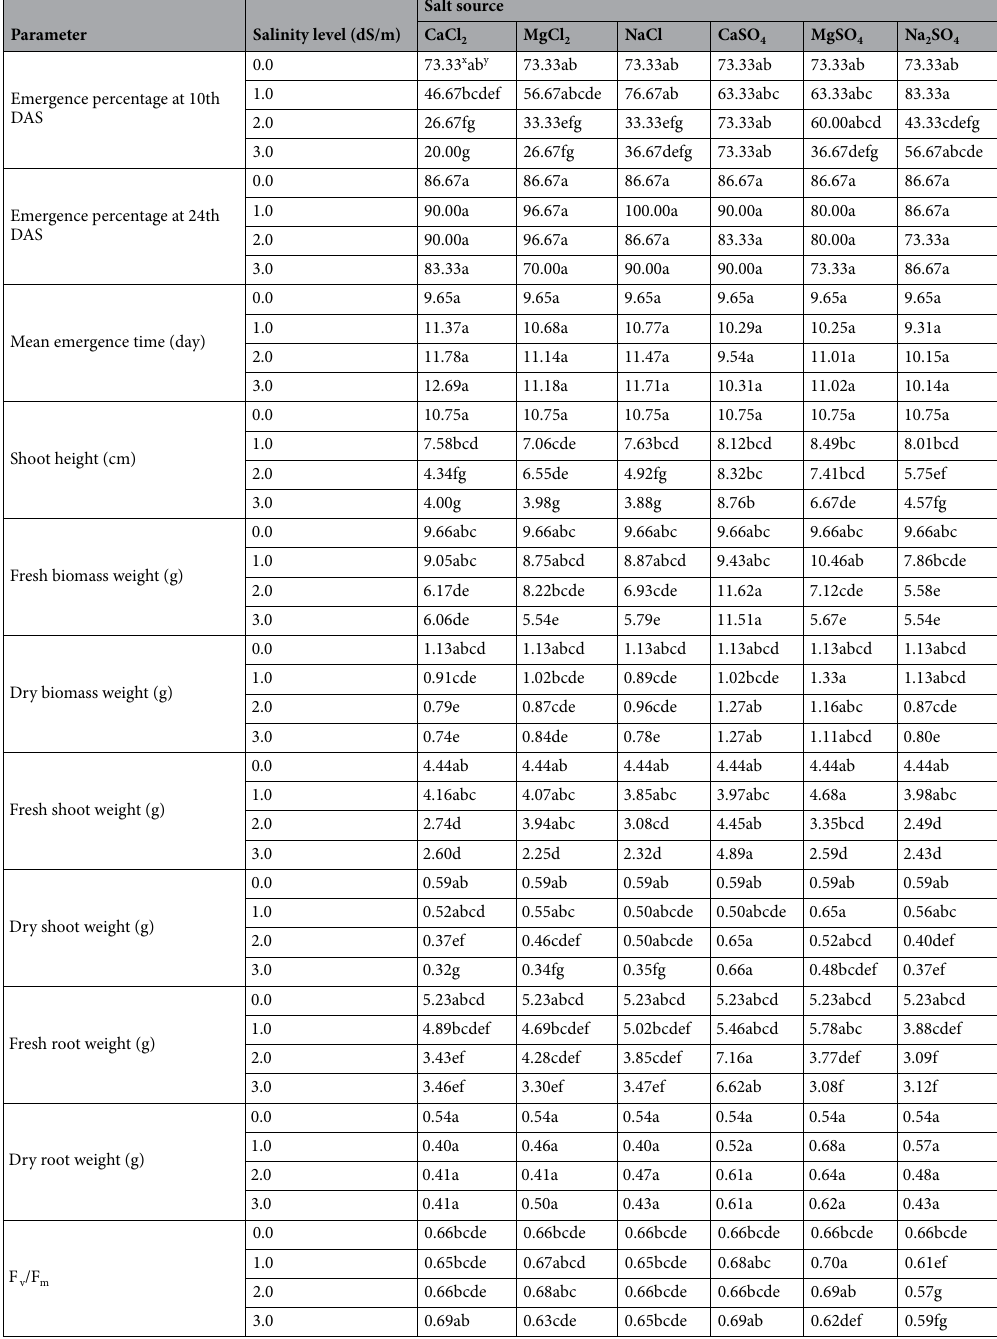
Table 3. The interaction effects of S × L on III-1 faba bean genotype. x Each value is the mean of three replications. y Within salt source and salinity level of each parameter, means followed by the same letter are not significantly different at the 5% level according to Duncan’s multiple range